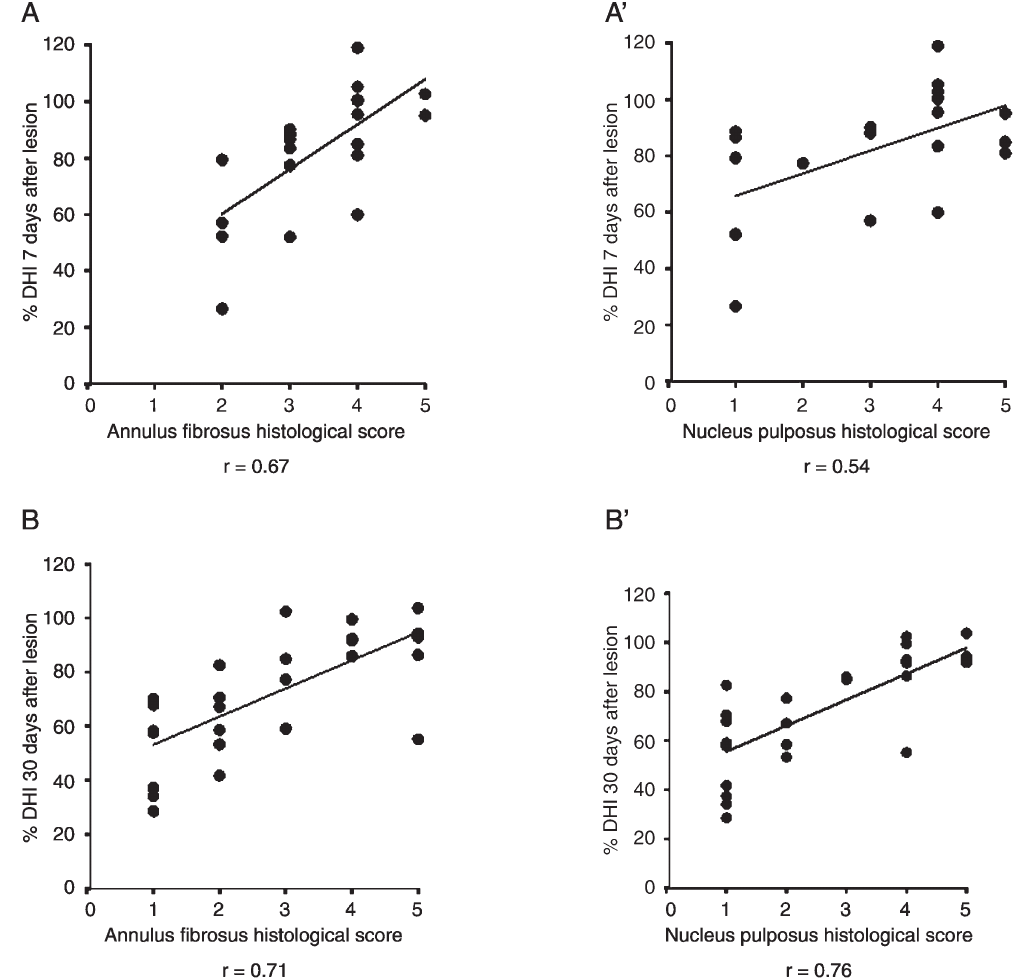
Figure 7. The graphs represent the linear regression of data obtained by radiographic and histological analysis of the nucleus pulposus and annulus fibrosus at 7 and 30 days after surgery. Pearson’s correlation coefficients obtained were: 7 days post-injury - annulus fibrosus: r = 0.67, P , 0.01 ( A ) and nucleus pulposus: r = 0.54, P , 0.05 ( A 9 ); 30 days after injury - annulus fibrosus: r = 0.71, P , 0.01 ( B ) and nucleus pulposus: r = 0.76, P , 0.01 ( B 9 ). DHI = disc height